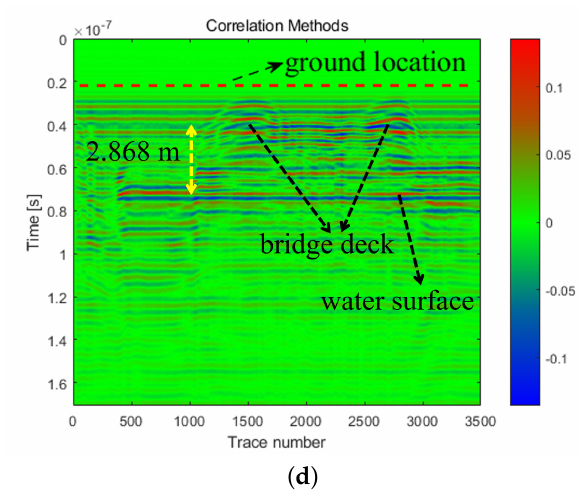
Figure 16. The measurement results of the bridge experiments. ( a ) Original data. ( b ) Mean subtraction method. ( c ) Moving average method. ( d ) Proposed CCBS method. The red line at the top of the figure